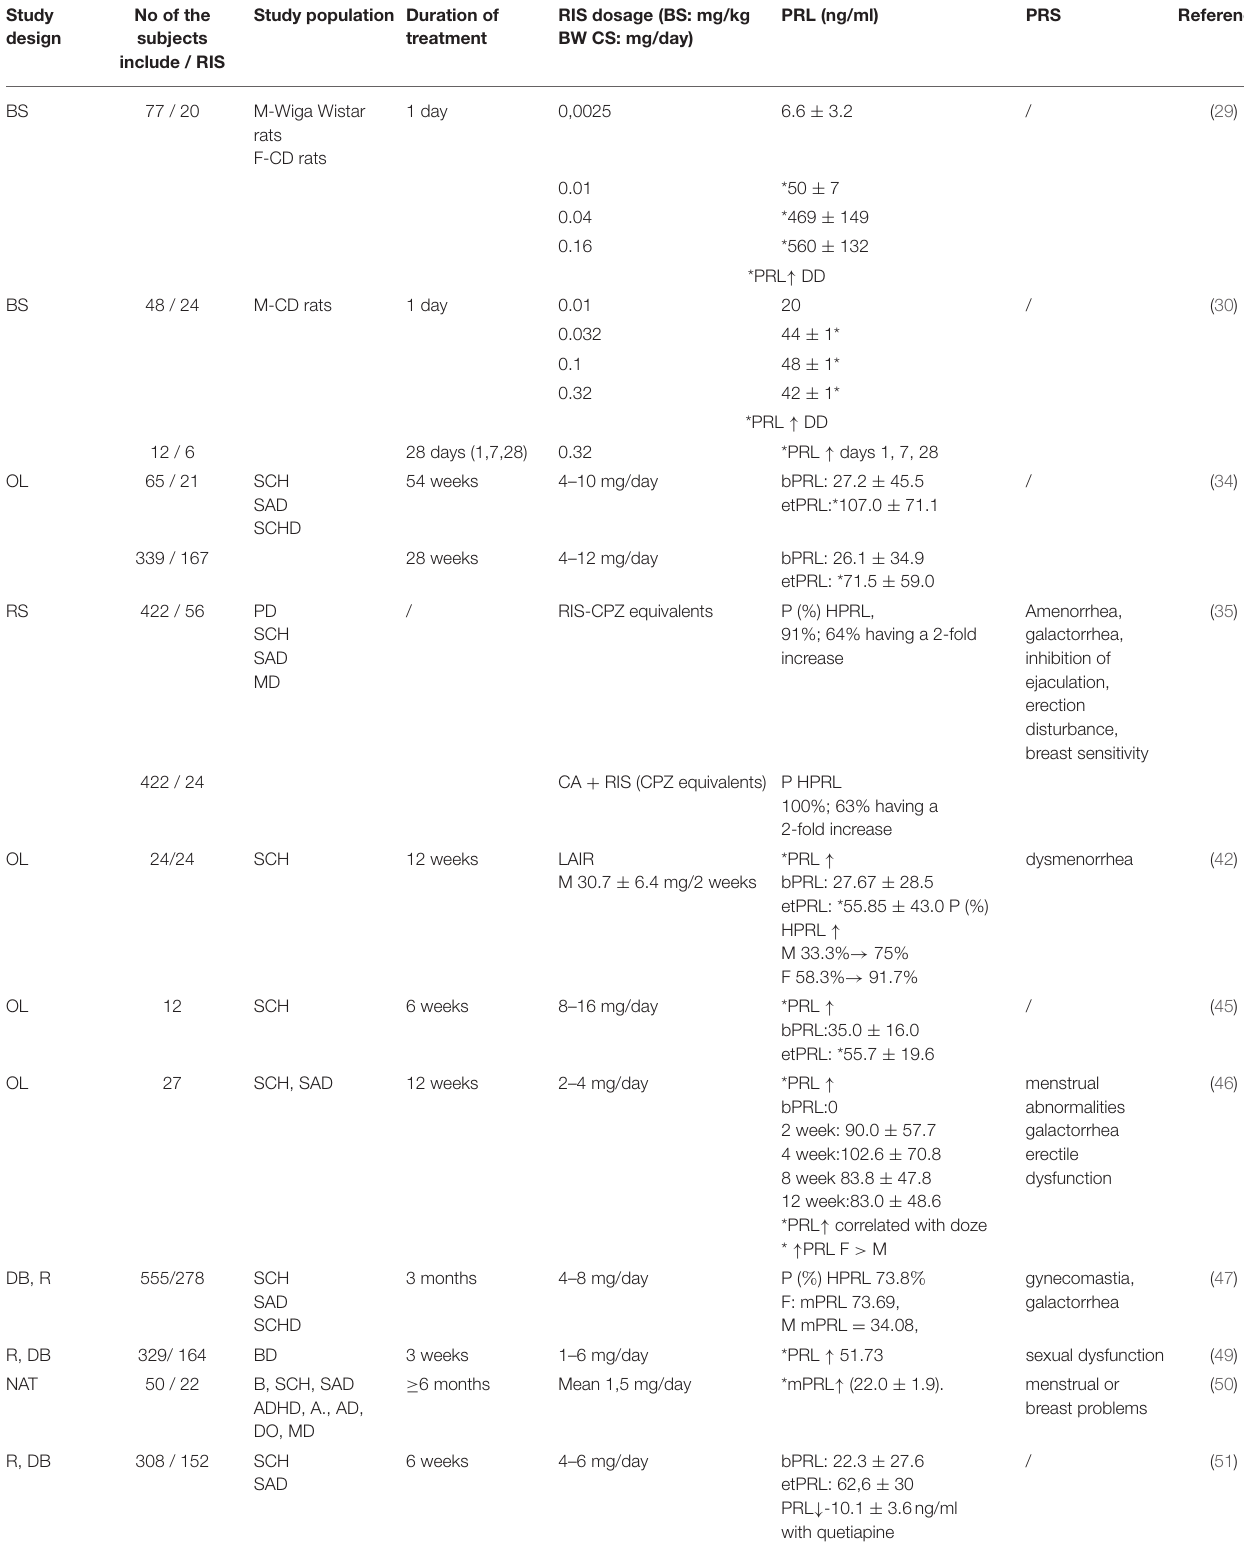
TABLE 2 | Main findings related to basic and clinical studies. Study